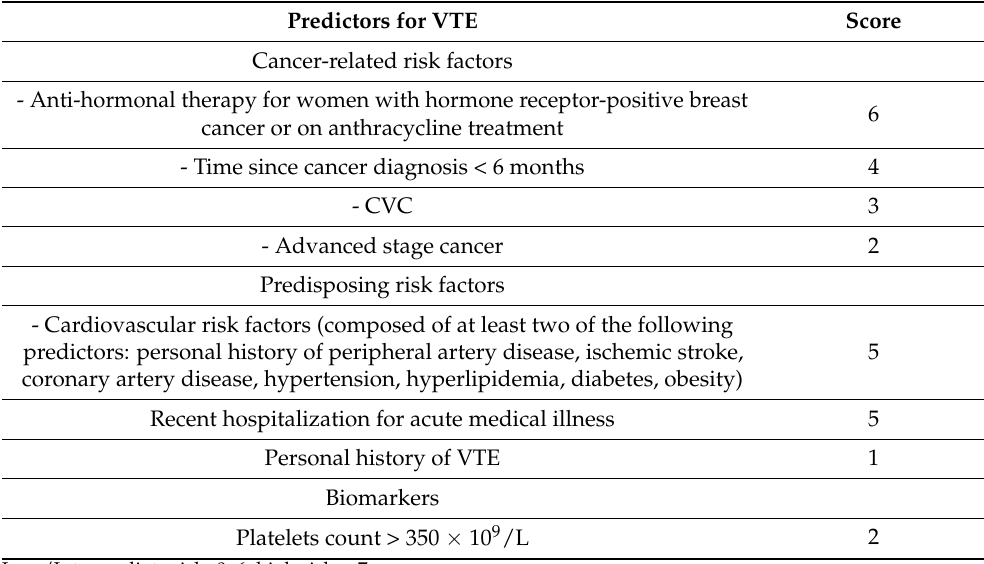
Table 4. COMPASS-KAT VTE risk score assessment.